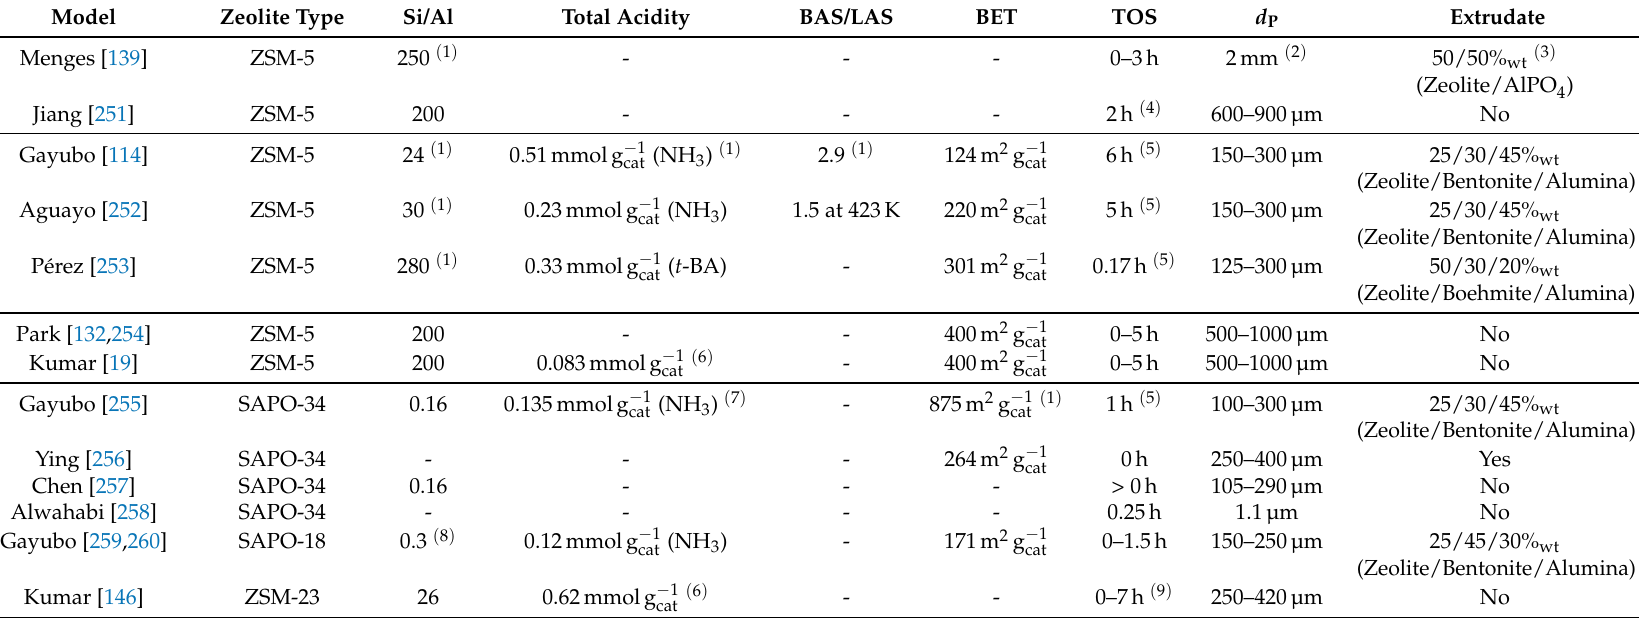
(1) Value of the zeolite, i.e., without binder. (2) Diameter of the cylindrical pellets used in this study (length = 5mm). (3) Dry basis. (4) Additional TOS of 50h to reach a plateau with constant propene yields. (5) Results extrapolated to 0h TOS. (6) Calculated via the Si/Al ratio. (7) Extracted from an earlier publication [261]. (8) Value of the gel [151]. (9) Converted to an effective space time to describe a non-deactivated